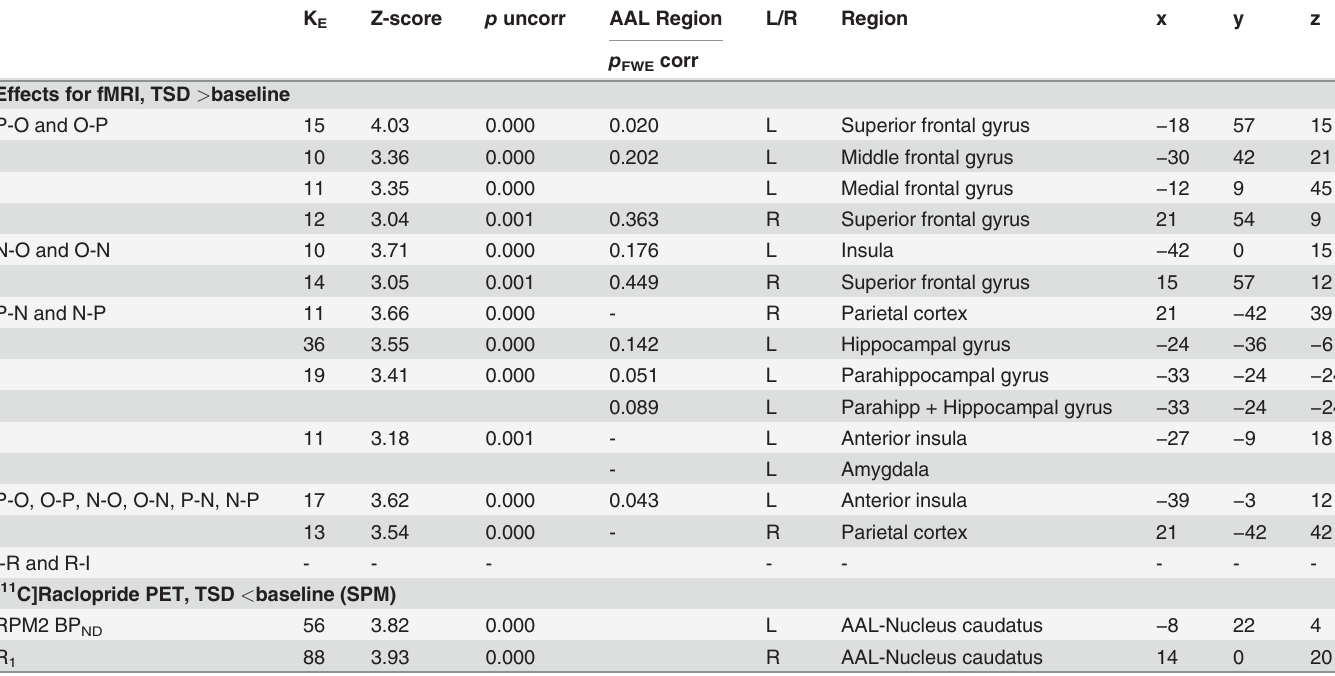
Table 4. Neuroimaging effects of TSD for fMRI and